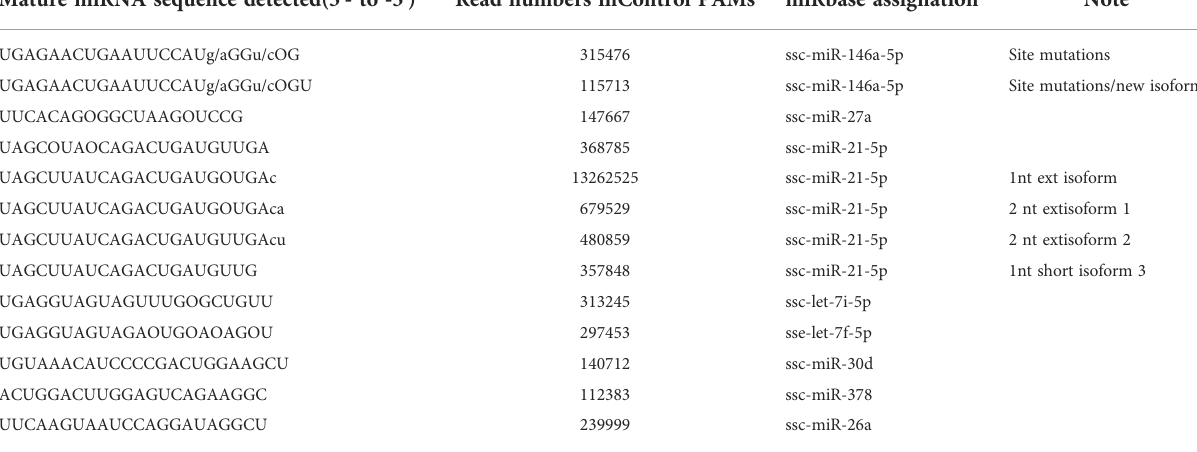
TABLE 5 Top enriched miRNA that each had >10,000 reads as exempli fi ed from the control P1 sample. Mature miRNA sequence detected(5'- to -3')*